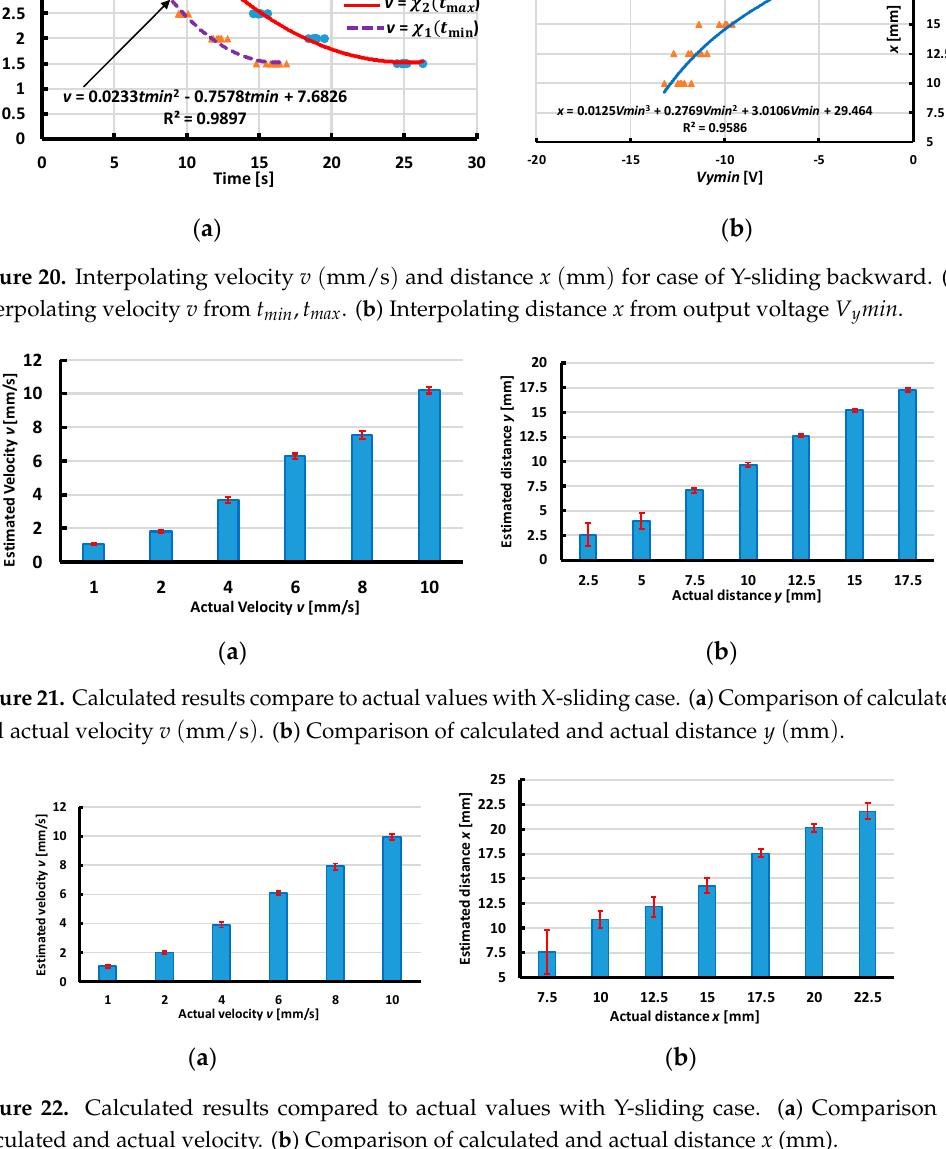
Figure 20. Interpolating velocity 𝑣 (mm/s) and distance 𝑥 (mm) for case of Y-sliding backward. ( a ) Interpolating velocity 𝑣 from 𝑡 (cid:3040)(cid:3036)(cid:3041) , 𝑡 (cid:3040)(cid:3028)(cid:3051) . ( b ) Interpolating distance 𝑥 from output voltage 𝑉 (cid:3052) 𝑚𝑖𝑛 .